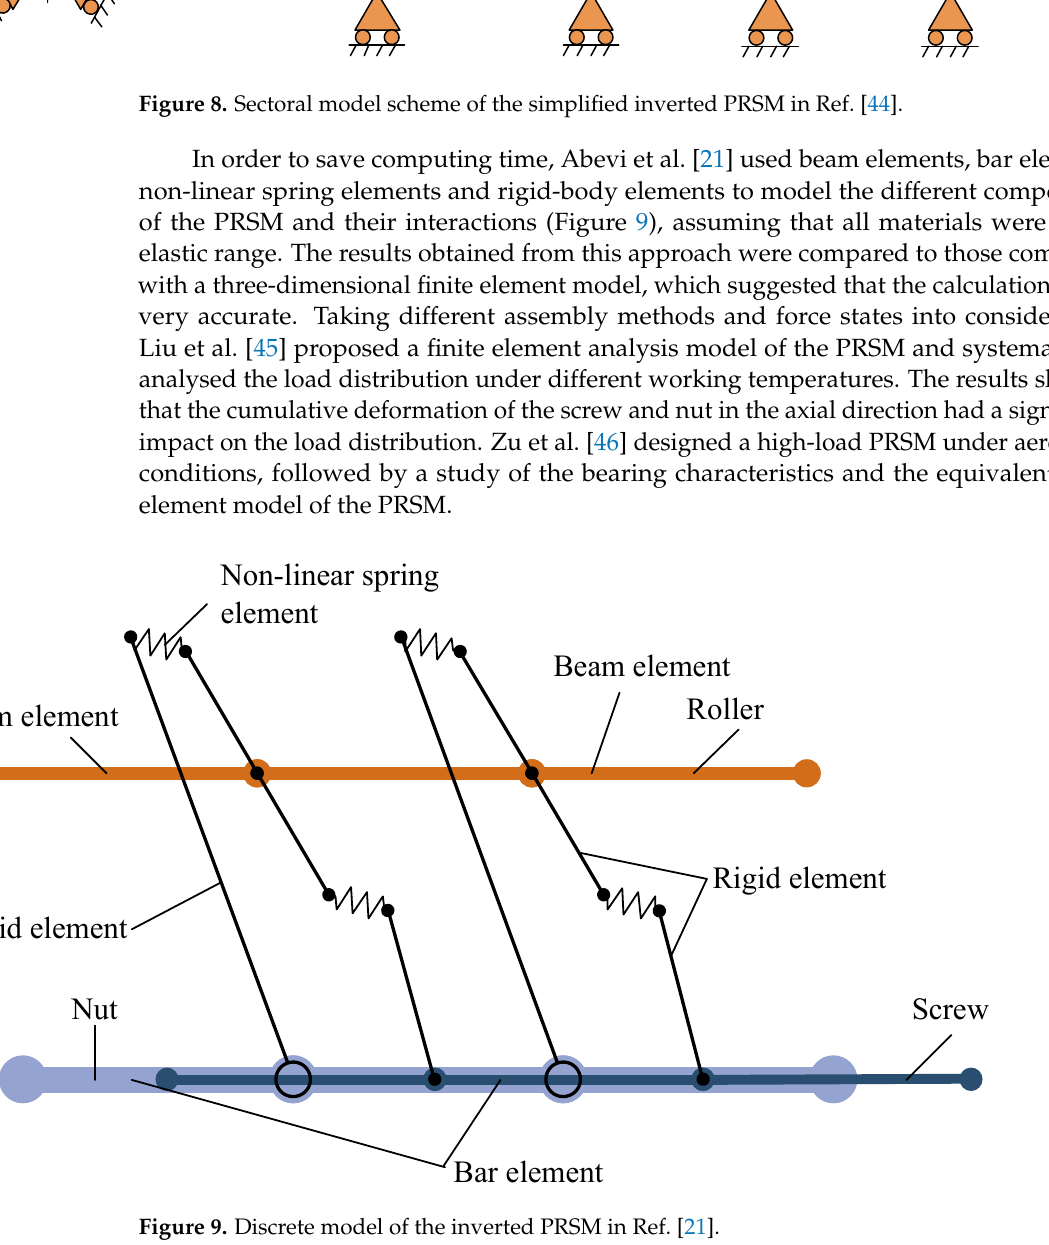
Figure 8. Sectoral model scheme of the simplified inverted PRSM in Ref. [44].